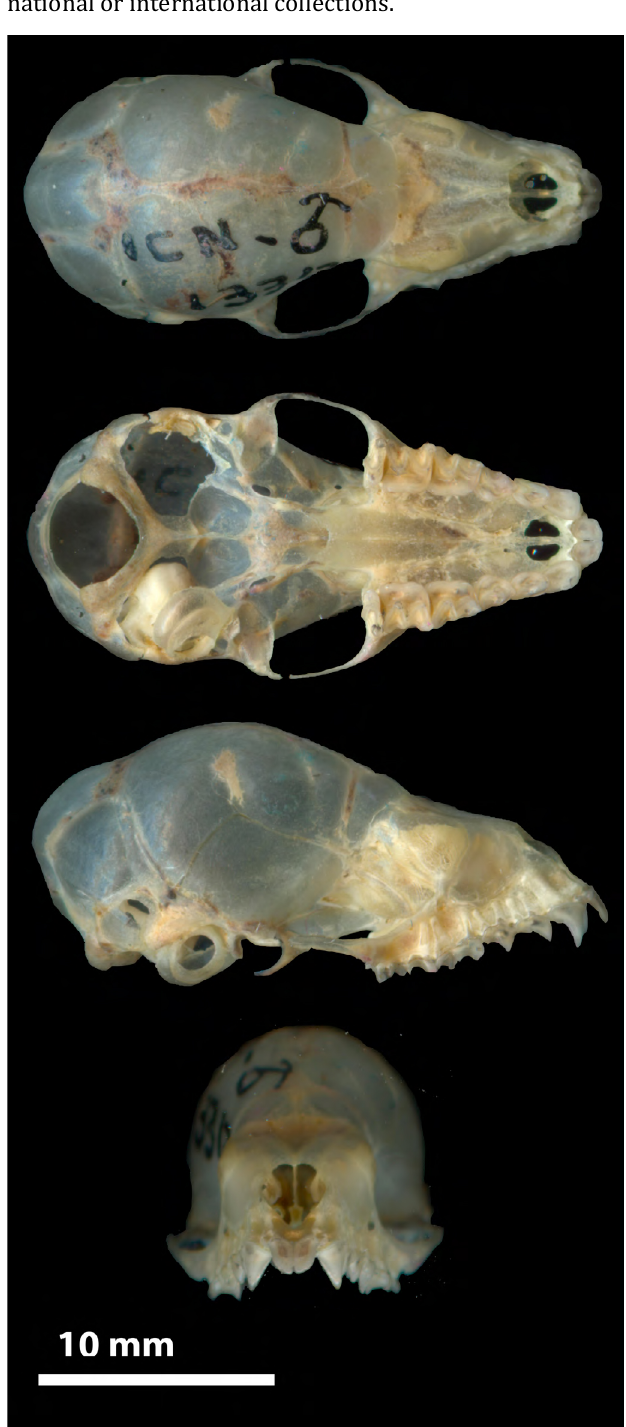
Figure 2. Glyphonycteris sylvestris Dorsal (upper), ventral (middle) and lateral (lower) view of the skull of (ICN 13313), with detail of size and shape of the central upper